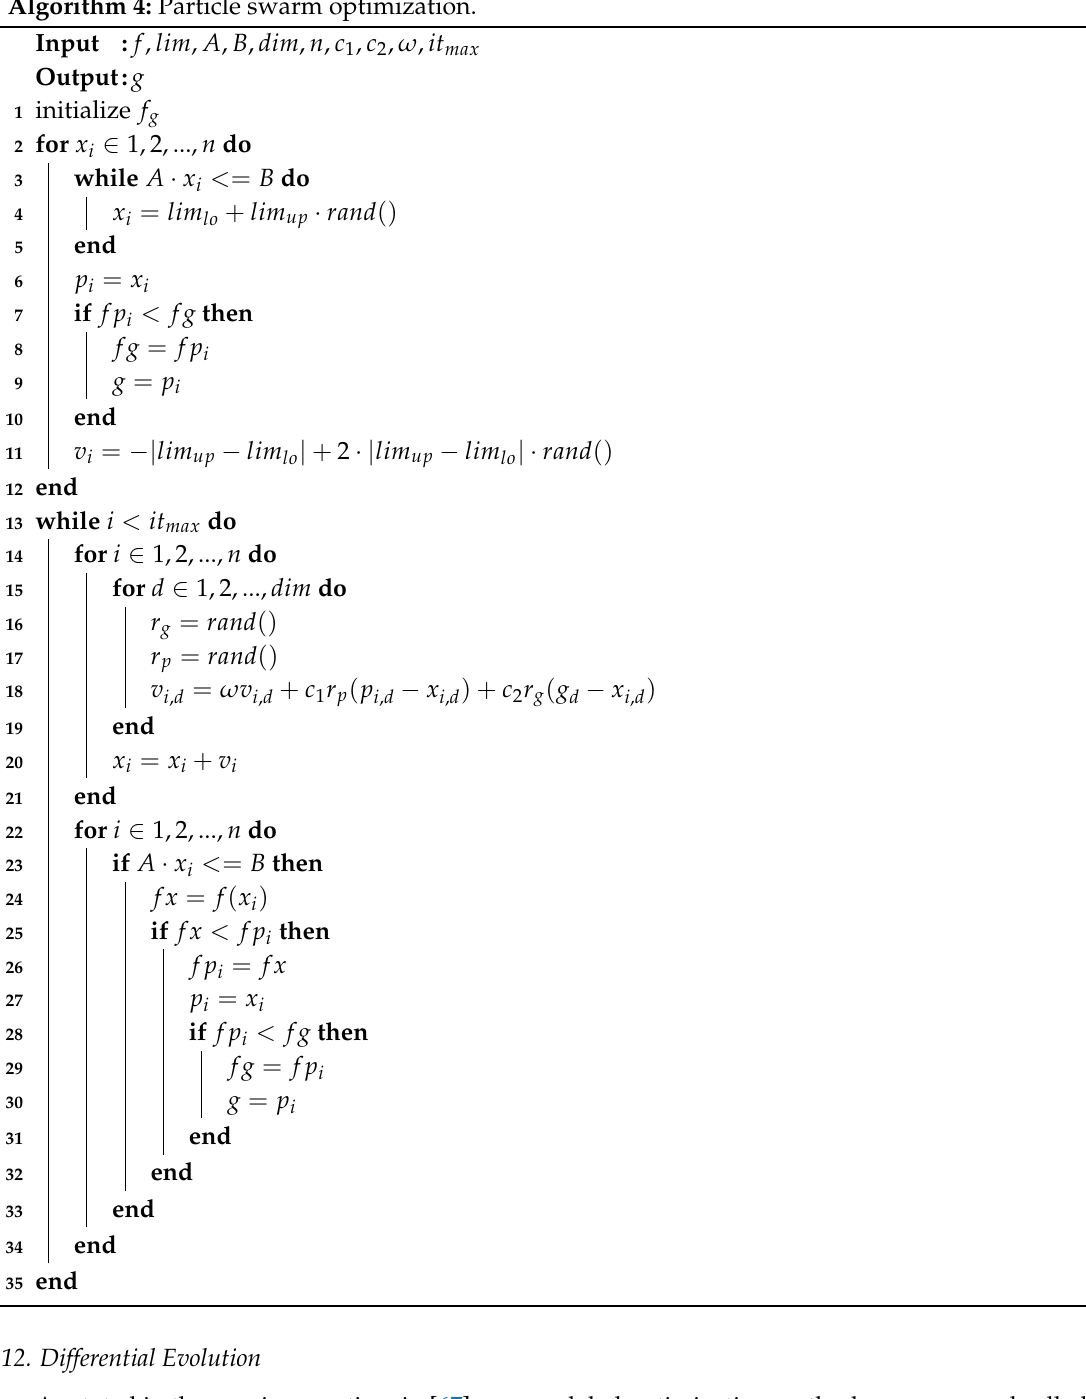
Algorithm 4: Particle swarm